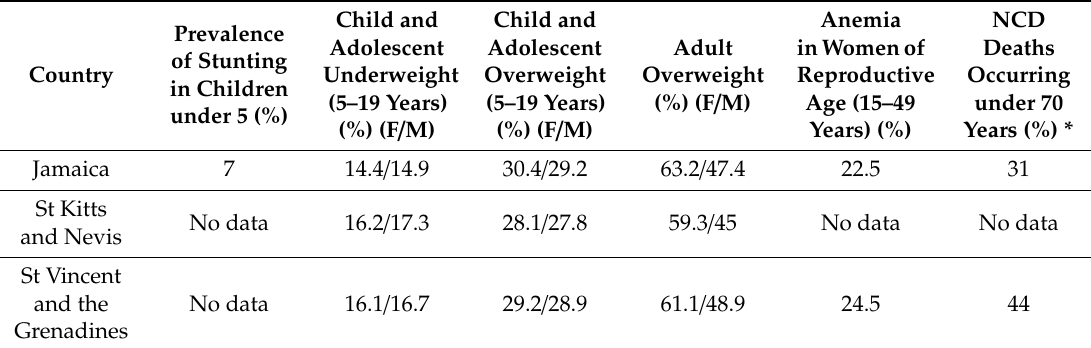
Table 1. Summary characteristics 1 on aspects of malnutrition in the three study countries.